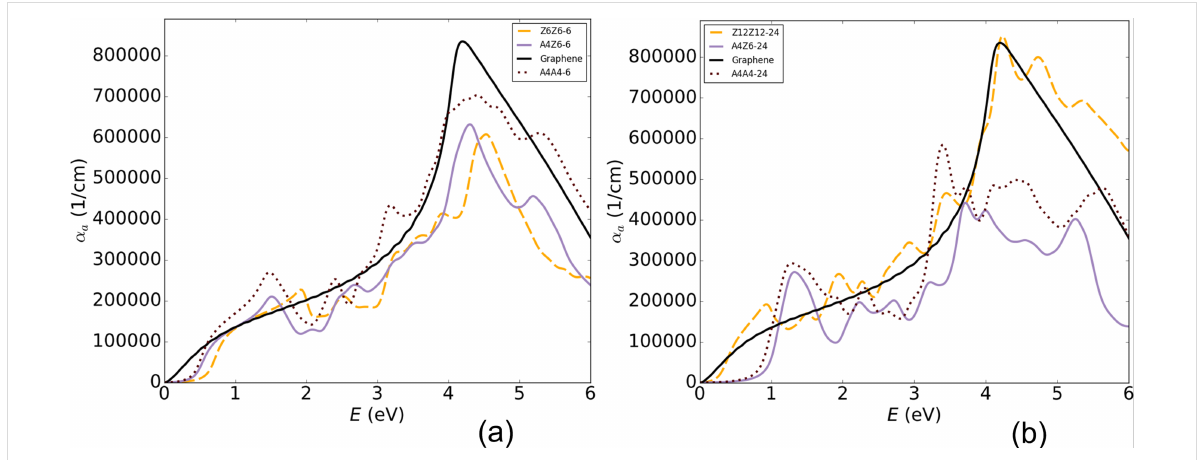
Figure 3: Absorption spectra of different GNM materials. (a) A4A4-6, Z6Z6-6 and A4Z6-6 and (b) A4A4-24, Z12Z12-24 and A4Z6-24.